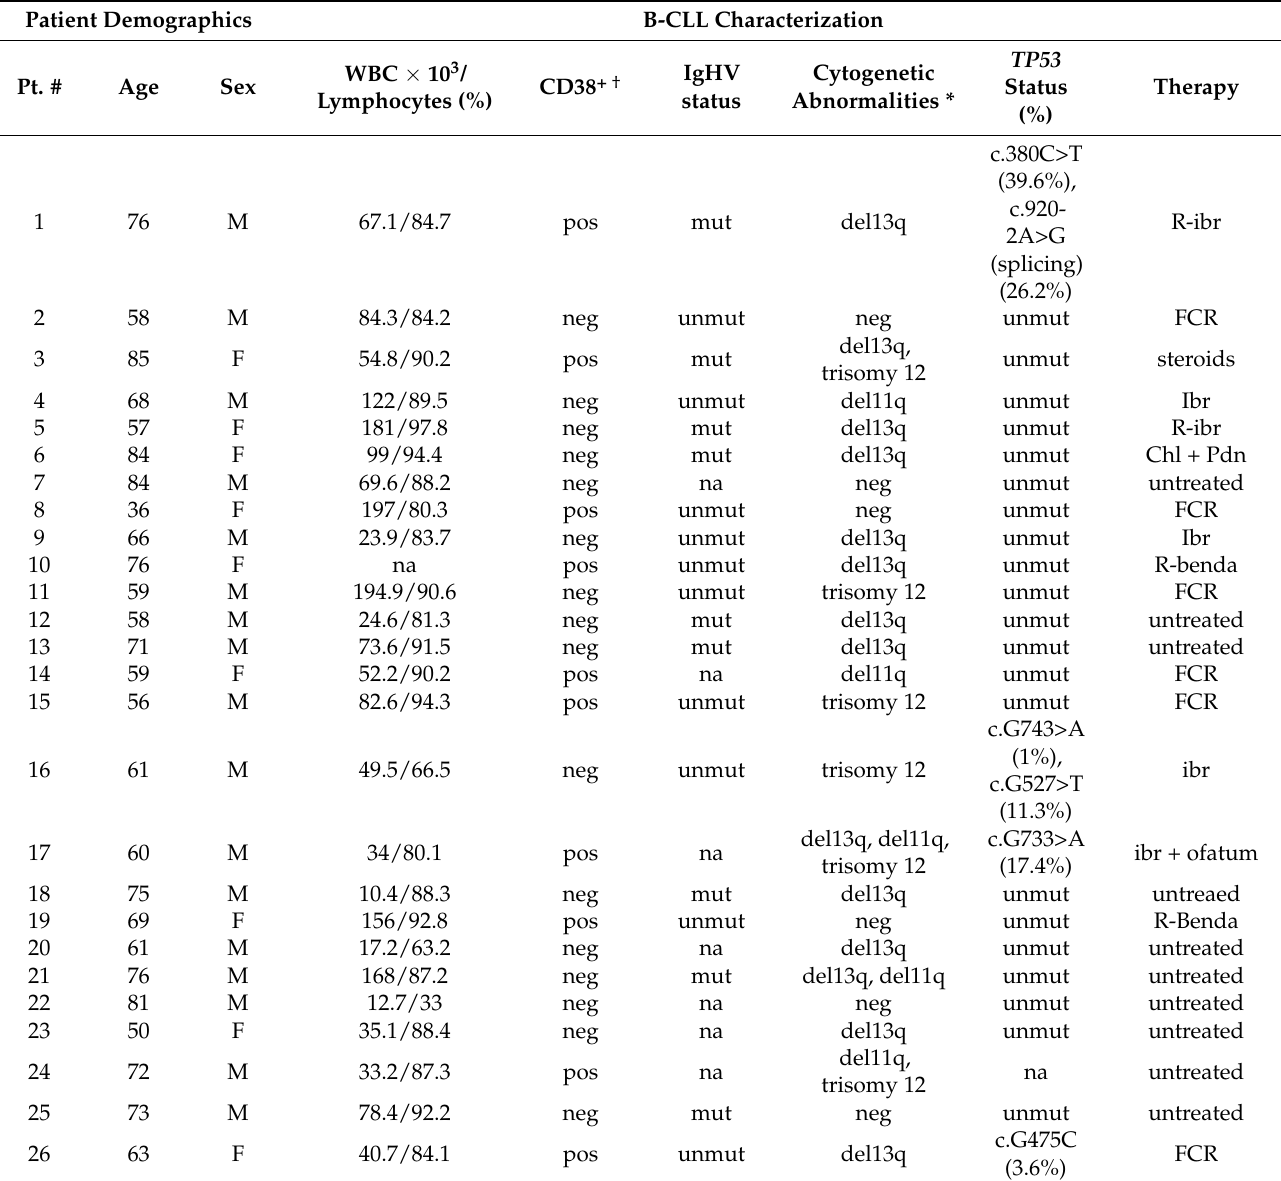
Table 1. Clinical and laboratory characteristics of B-CLL patients at the moment of the in vitro treatments. Patient